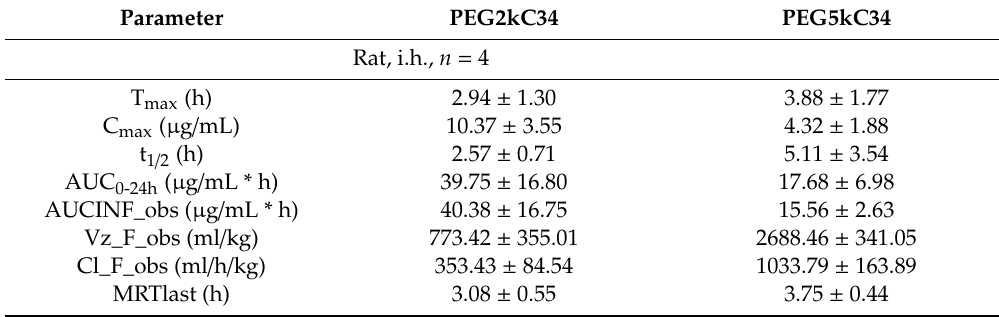
Figure 5. The ex vivo anti-HIV-1 activity of the peptides tested. ( A ) Three groups of SD rats (2 male and 2 female rats/group) were subcutaneously administered with peptides C34, PEG2kC34 and PEG5kC34, respectively, and rat plasma were harvested before injection and at different time points (0.5, 1.0, 2.0, 4.0, 6.0, 8.0, 10.0 and 24.0 h) after injection. ( B ) Antiviral activities of C34, PEG2kC34 and PEG5kC34 in rat plasma. Plasma dilutions required for 50% inhibition of HIV-1 strain NL4-3infection were determined. ( C ) Concentration of the active peptides in the plasma samples was estimated. Error bars represent the standard deviation of each mean. Table 2. Pharmacokinetic parameters of PEG2kC34 and PEG5kC34 in rats.